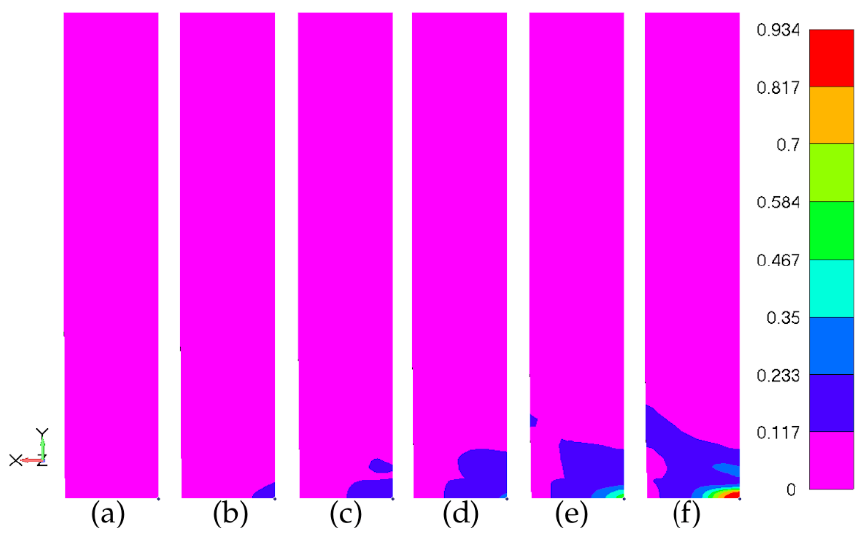
Figure 15. Effect of the mesh size on the force–displacement response.